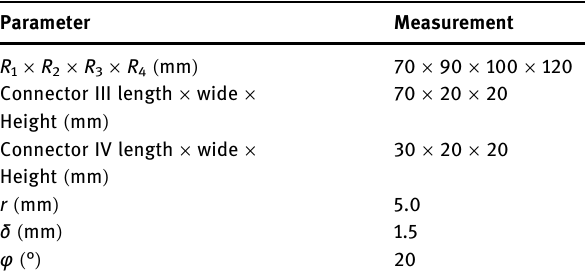
Table 1: Structural parameters of elastic tube bundle Parameter Measurement